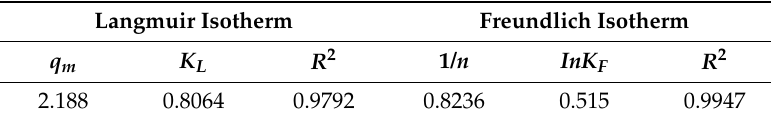
Table 2. Parameters of adsorption isotherm